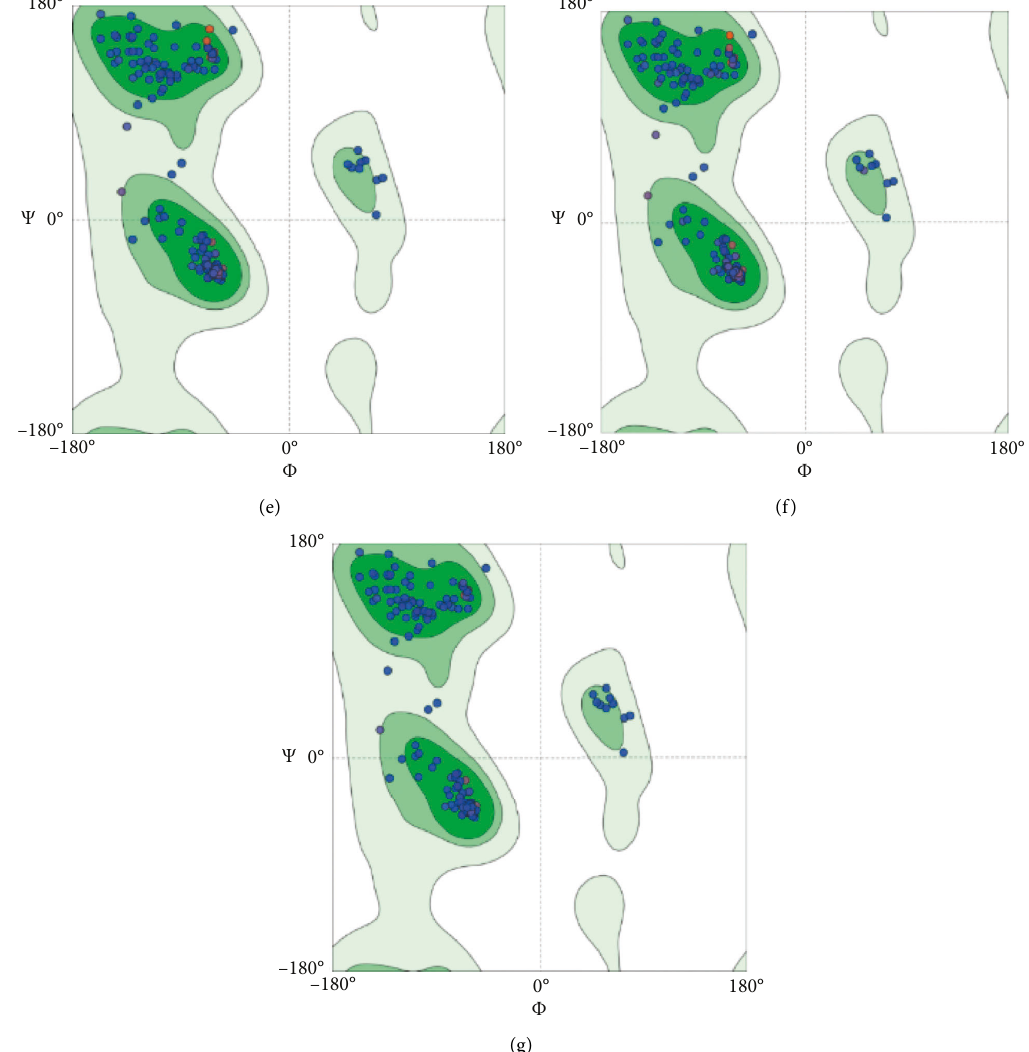
Figure 6: Ramachandran plots on the models from the Rab7 sequences (listed in Figure 5) of (a) Actinia tenebrosa (Ramachandran favored 96.70%, Ramachandran outliers 0%, rotamer outliers 1.88%), (b) Lingula anatina (Ramachandran favored 96.70%, Ramachandran outliers 0%, rotamer outliers 1.88%), (c) Lottia gigantea (Ramachandran favored 96.70%, Ramachandran outliers 0%, rotamer outliers 1.86%), (d) Capitella teleta (Ramachandran favored 88.95%, Ramachandran outliers 3.31%, rotamer outliers 5%), (e) Priapulus caudatus (Ram- achandran favored 96.70%, Ramachandran outliers 0%, rotamer outliers 1.86%), (f) Daphnia magna (Ramachandran favored 96.70%, Ramachandran outliers 0%, rotamer outliers 1.24%), and (g) Cyprinodon variegatus (Ramachandran favored 96.70%, Ramachandran outliers 0%, rotamer outliers 1.85%) (MolProbity results were obtained by MolProbity version